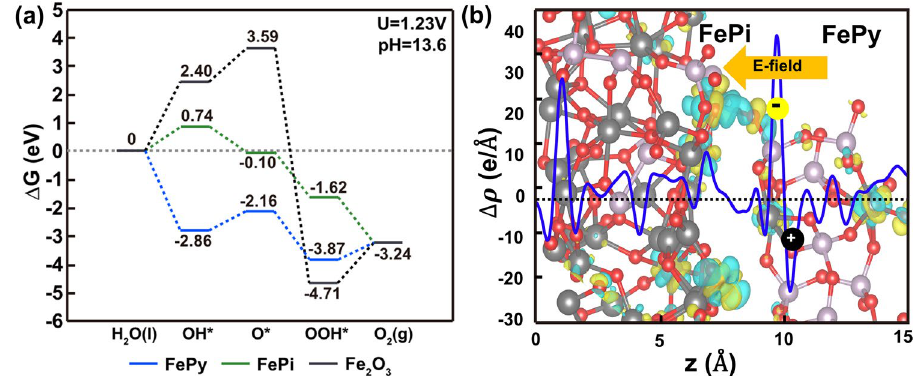
Fig. 7 a Adsorption free energy diagrams of OER on crystalline FePy, FePi, and α- Fe 2 O 3 (0 1 2) surface under the conditions of U = 1.23 V versus RHE and pH = 13.6 from DFT. b The plane‑averaged differential charge densities at the FePi/FePy